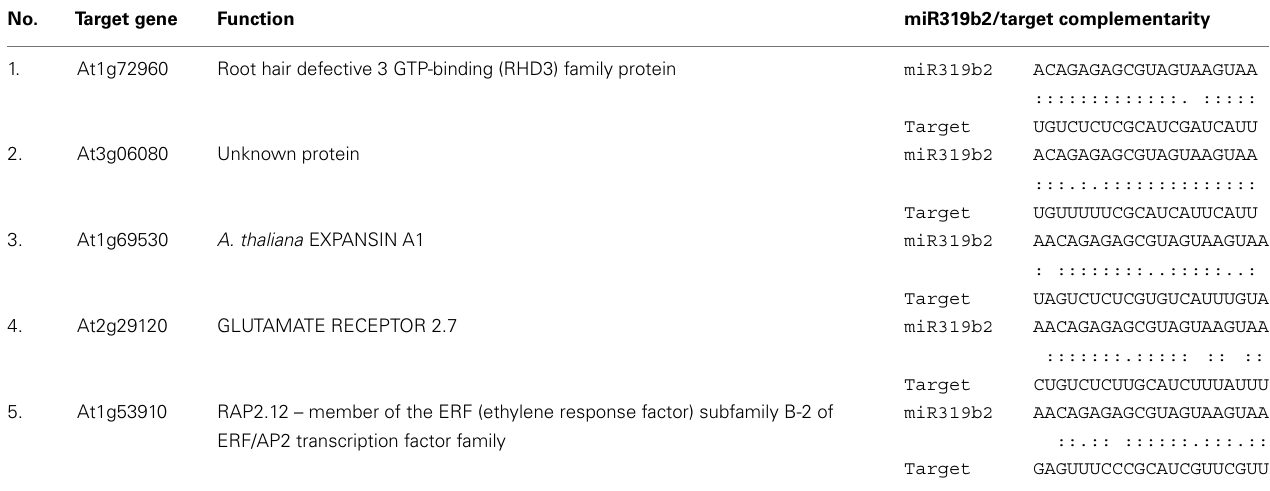
TableA2 | Five protein-coding genes selected as putative targets for miR319b.2.